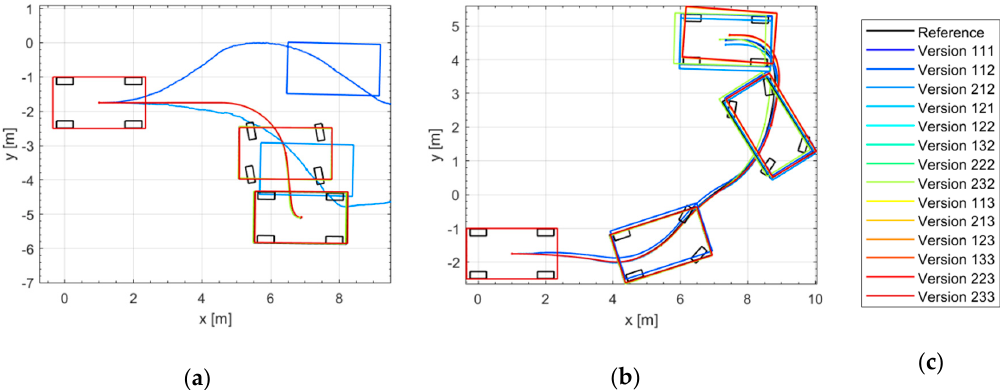
Figure 18. Simulation results of different odometry versions: ( a ) Trajectories in DM1; ( b ) Trajectories in DM3; ( c ) Legend.